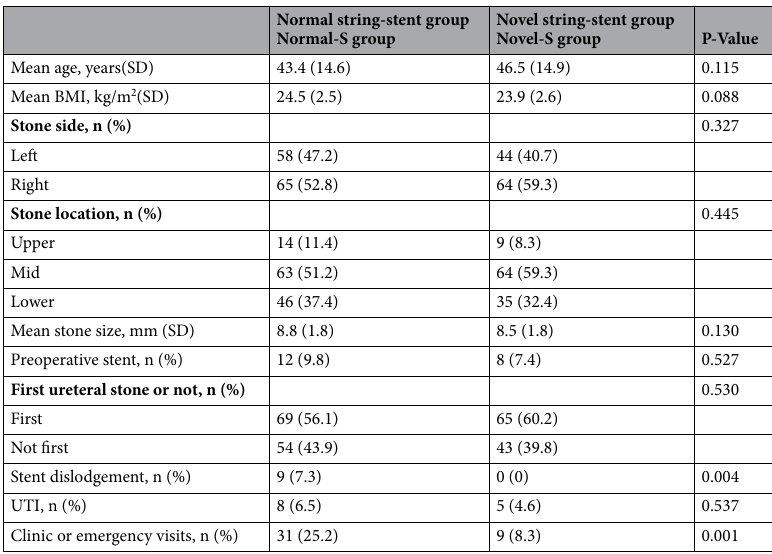
Table 1. Demographics of the two groups and complications related to stent